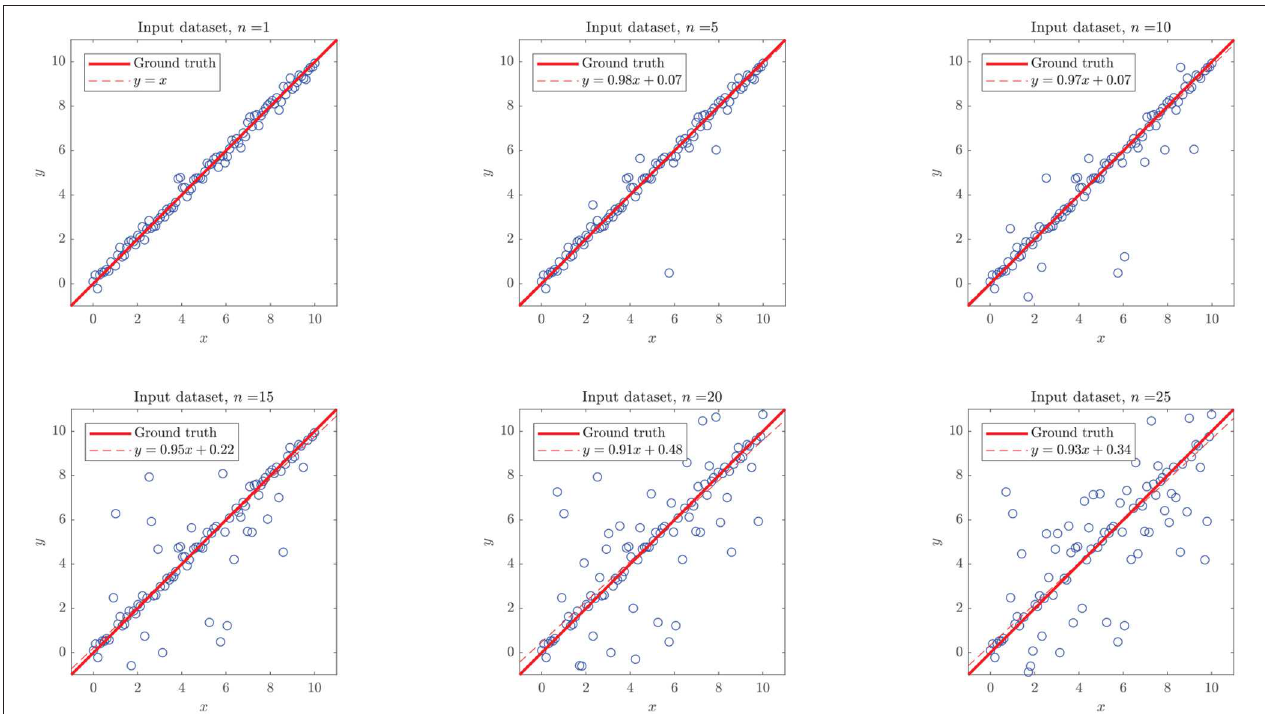
FIGURE 10 | Simulated linear dataset with n outliers in 100 data points. The added outliers modify the nature of the distribution, as they make the regression considerably drift from the identity. In such sense, those outliers might not be “pure” in a strict statistical definition (as they depend on the distribution), they drift considerably from the expected values of the original